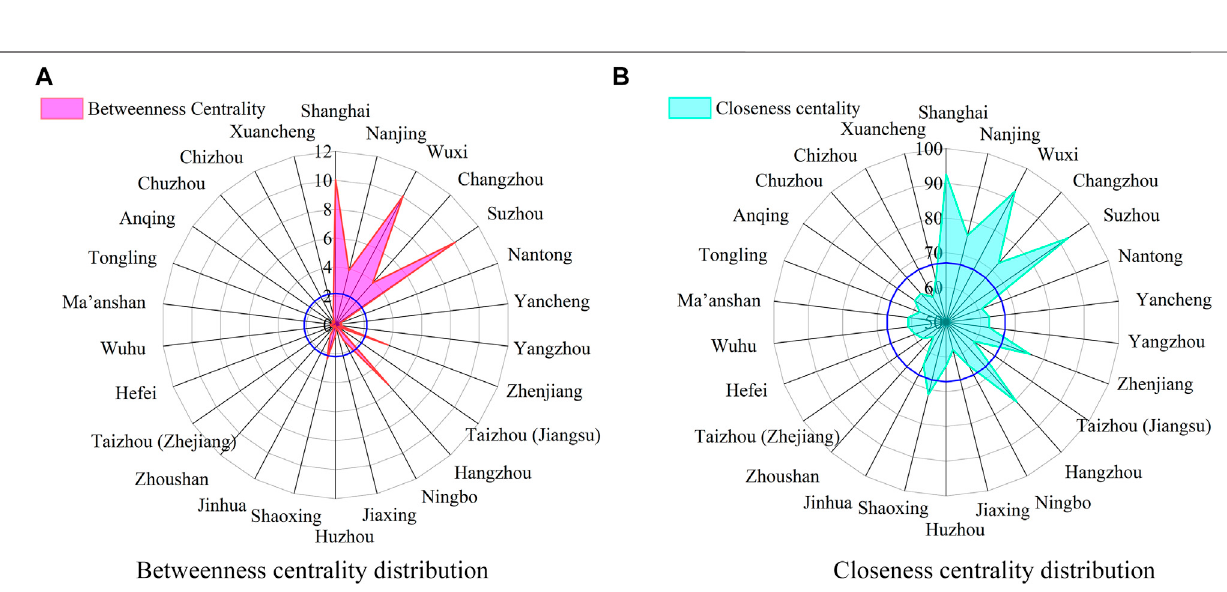
Frontiers in Environmental Science |